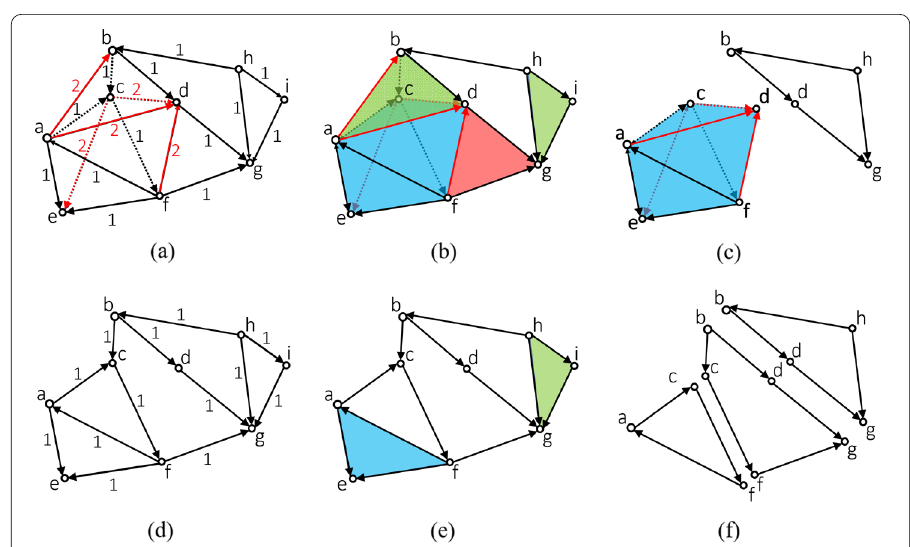
Figure 4 Patterns within subnetworks. ( a ) The toy network in Fig. 2 with edge weights assigned. ( b ) The associated directed clique complex of the entire directed network in ( a ). ( c ) A 1-cycle consisting of the sum of four directed edges and a 2-cycle consisting of the sum of six 2-simplices embedded in the directed clique complex in ( b ). ( d ) A subnetwork obtained by including only edges of weight exactly 1. ( e ) The associated directed clique complex of the subnetwork in ( c ). ( f ) Three 1-cycles detected in the directed clique complex in ( e